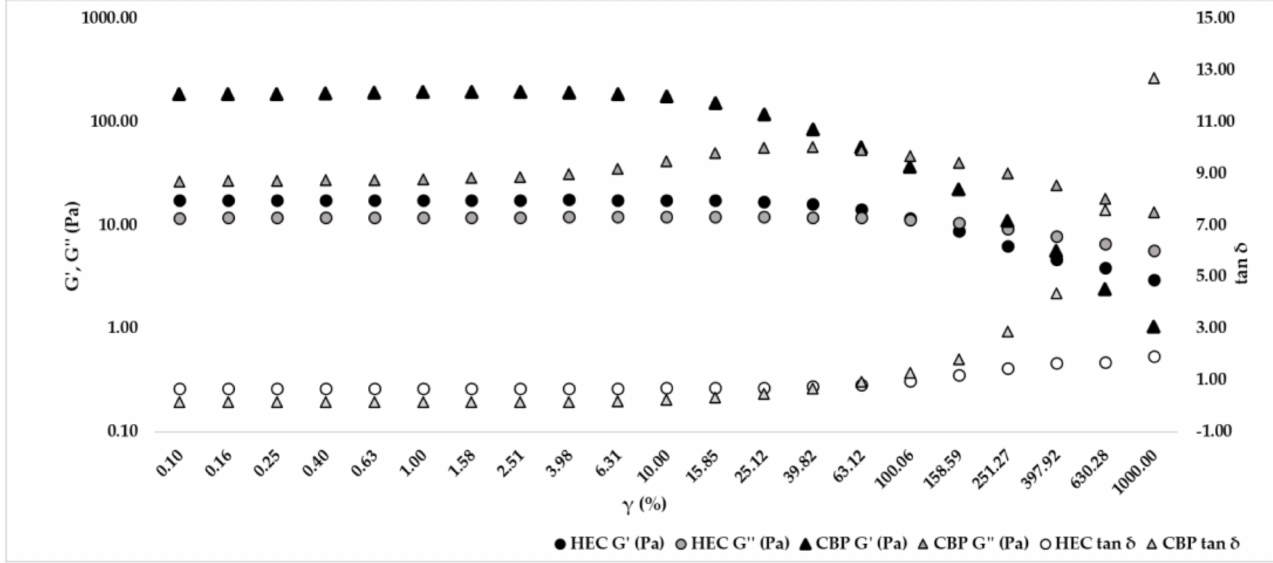
Figure 2. Graphical representation of the results obtained from the amplitude sweep test of formu- lation with hydroxyethylcellulose (HEC) and formulation with carbopol (CBP) at a temperature of 25 ◦ C and at a frequency value of 1 Hz.